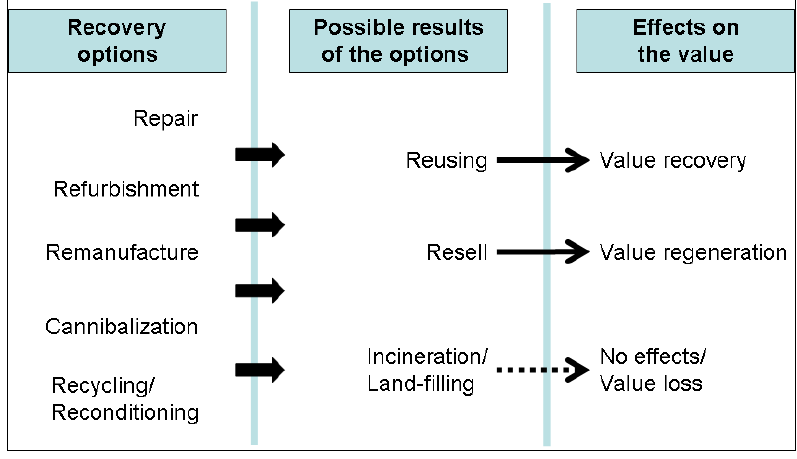
4. Direct Supply Chain, Reverse Supply Chain and Closed-Loop